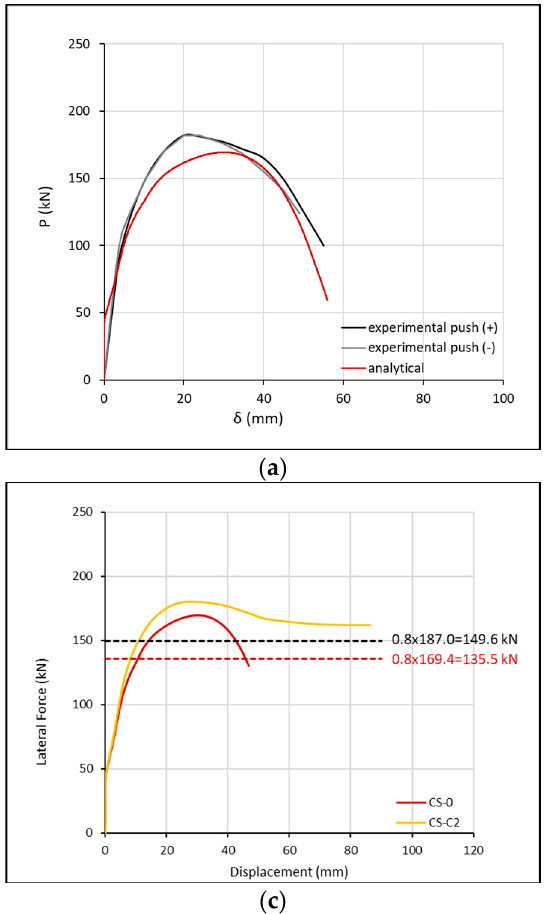
Figure 7. Comparative experimental (the envelope P- δ curve of the original experimental response) and analytical base shear force–displacement curve for specimens ( a ) CS-0; ( b ) CS-C2; ( c ) The comparison of their analytical P- δ curves.